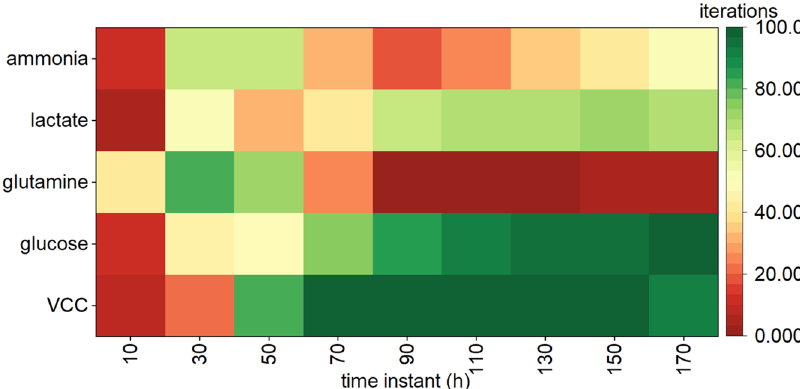
Figure 9. Process understanding for mAbs titer estimation through MPLS variable importance at each time point selection frequency: MPLS model calibrated with 8 process batches, randomly extracted from a subset of 10 batches contained in X PC and y PC , and 80 HDM in silico generated batches extracted from X H and y H , 10 for each of the corresponding calibration batches. MPLS variable importance at each time point.